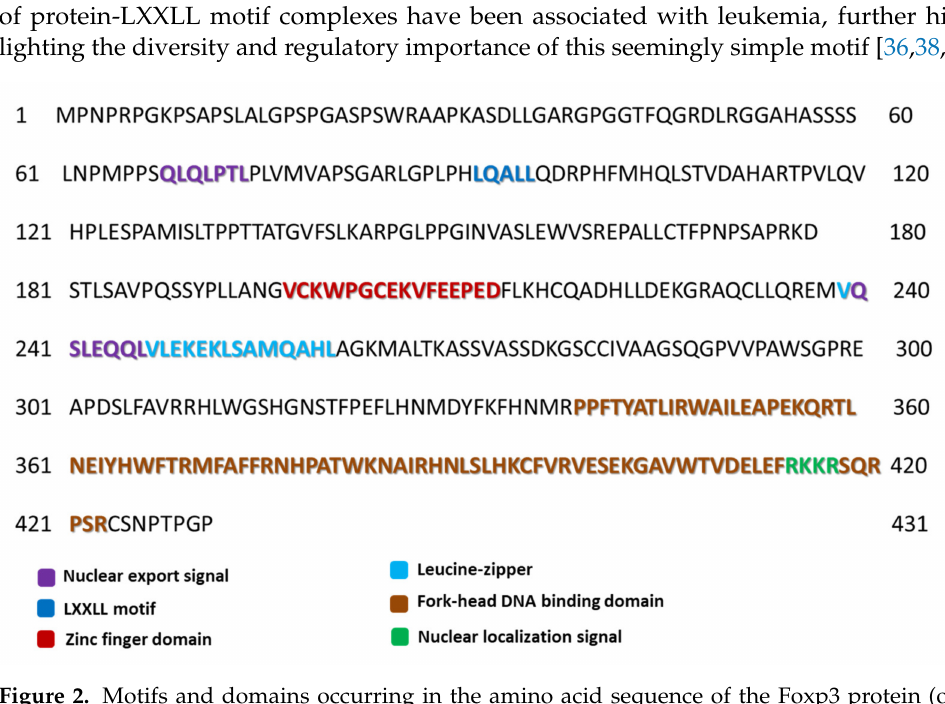
Figure 2. Motifs and domains occurring in the amino acid sequence of the Foxp3 protein (own elaboration based on the Uniprot database